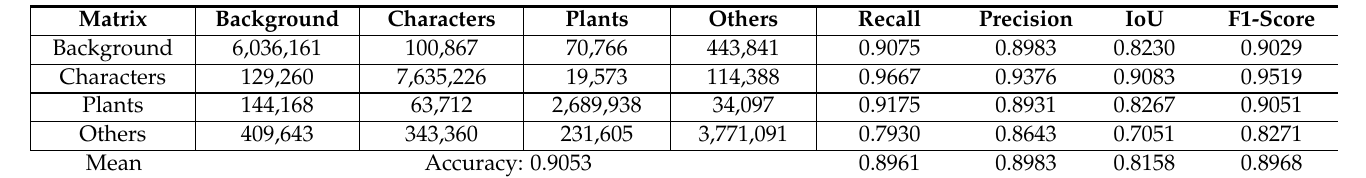
Table 1. Confusion matrix and evaluation metrics of the network on test data.